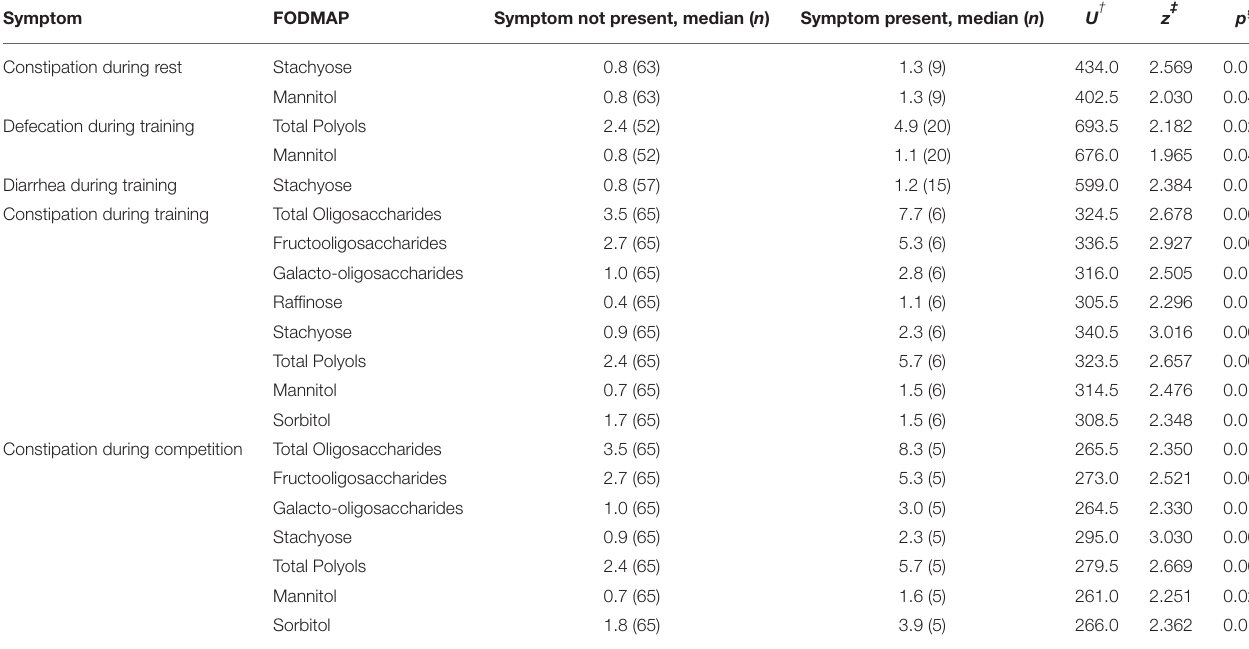
TABLE 6 | Significant differences in median fermentable oligosaccharides, disaccharides, monosaccharides, and polyols (FODMAP) intakes between individual symptom presence categories * . Symptom FODMAP Symptom not present, median ( n ) Symptom present, median ( n ) Constipation during